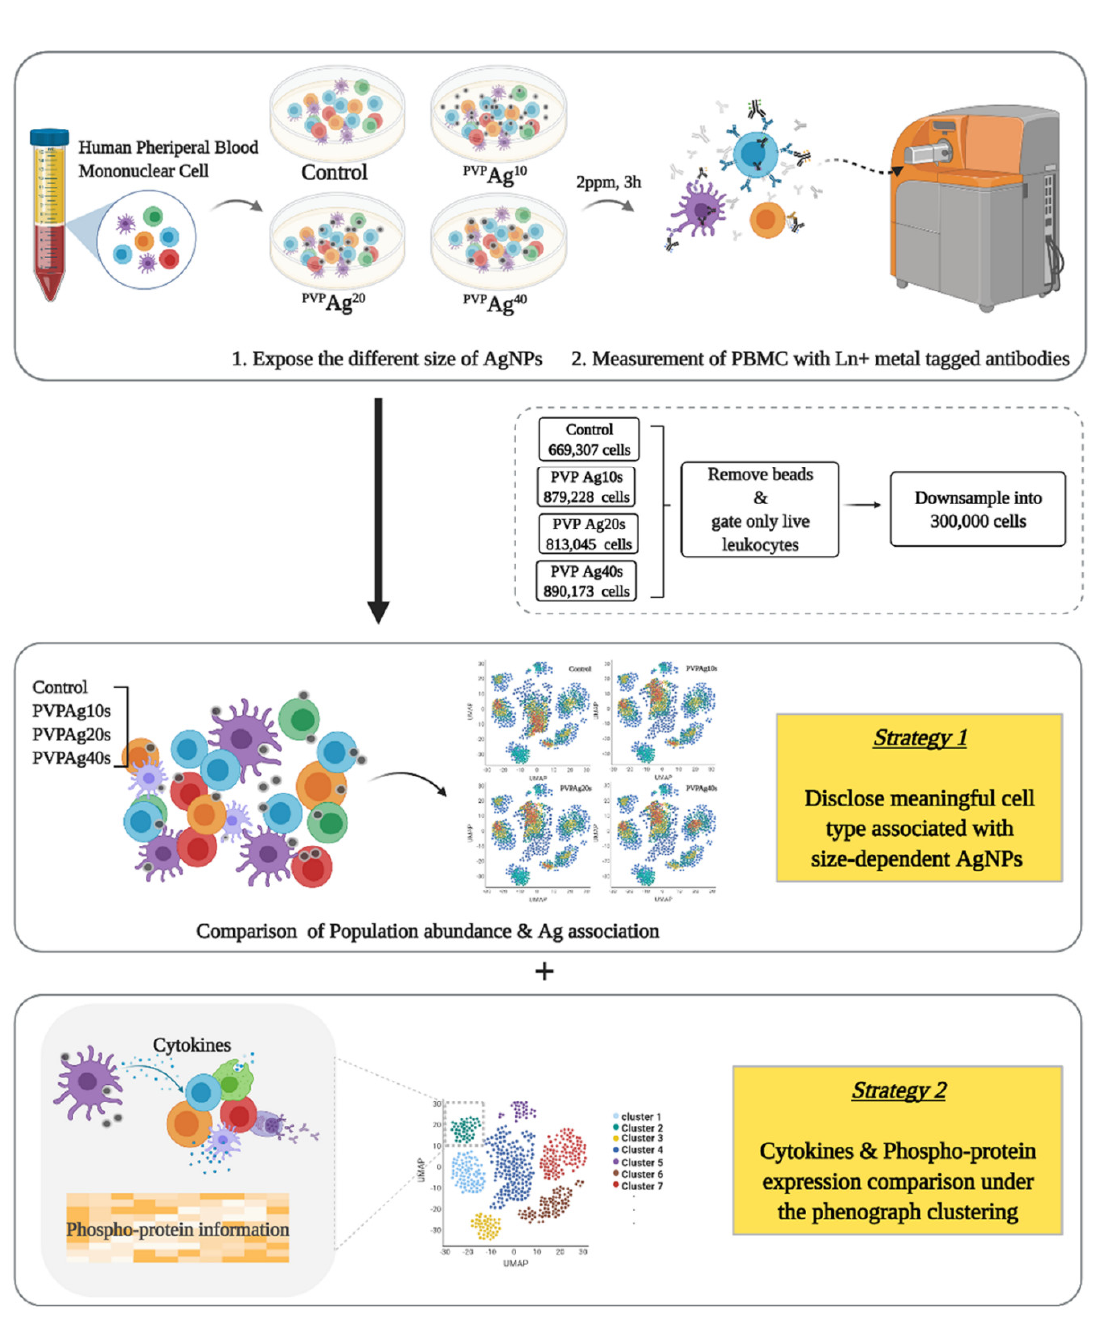
Figure 1. Schematic representation of analyzing pipeline of mass cytometry at single-cell resolution in human PBMC cells and dimensionality visualization performed by UMAP and PhenoGraph clustering to visualize data at single-cell resolution.